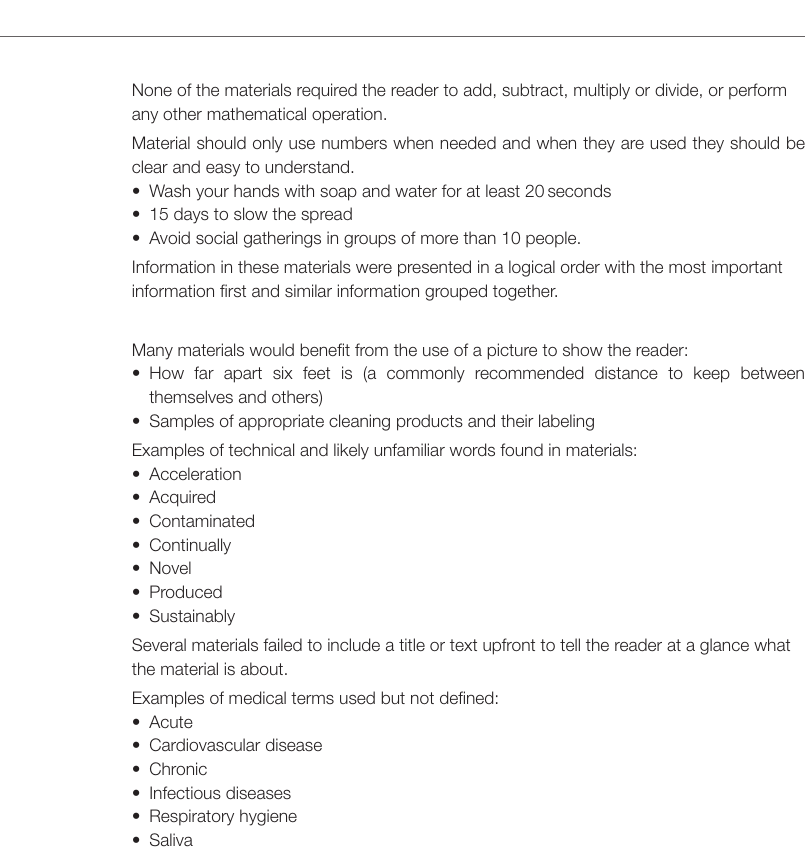
standard number